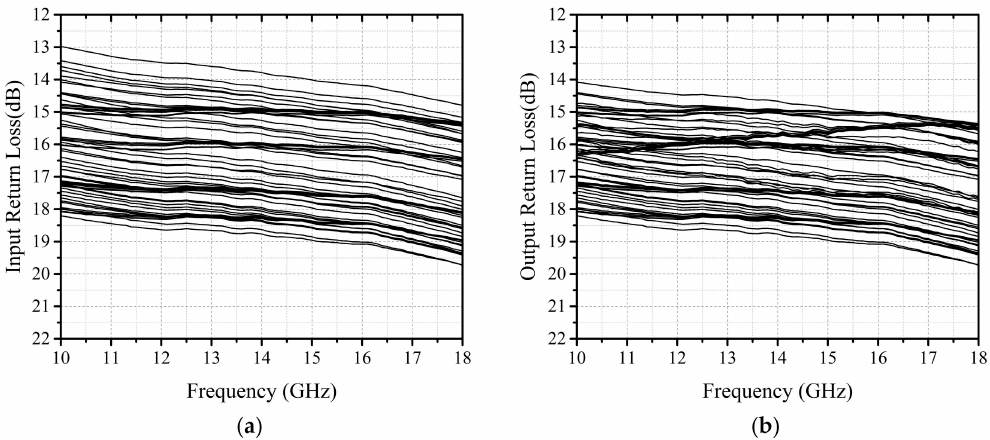
Figure 11. ( a ) The measured input return loss of the proposed attenuator; ( b ) the measured output return loss of the proposed attenuator.